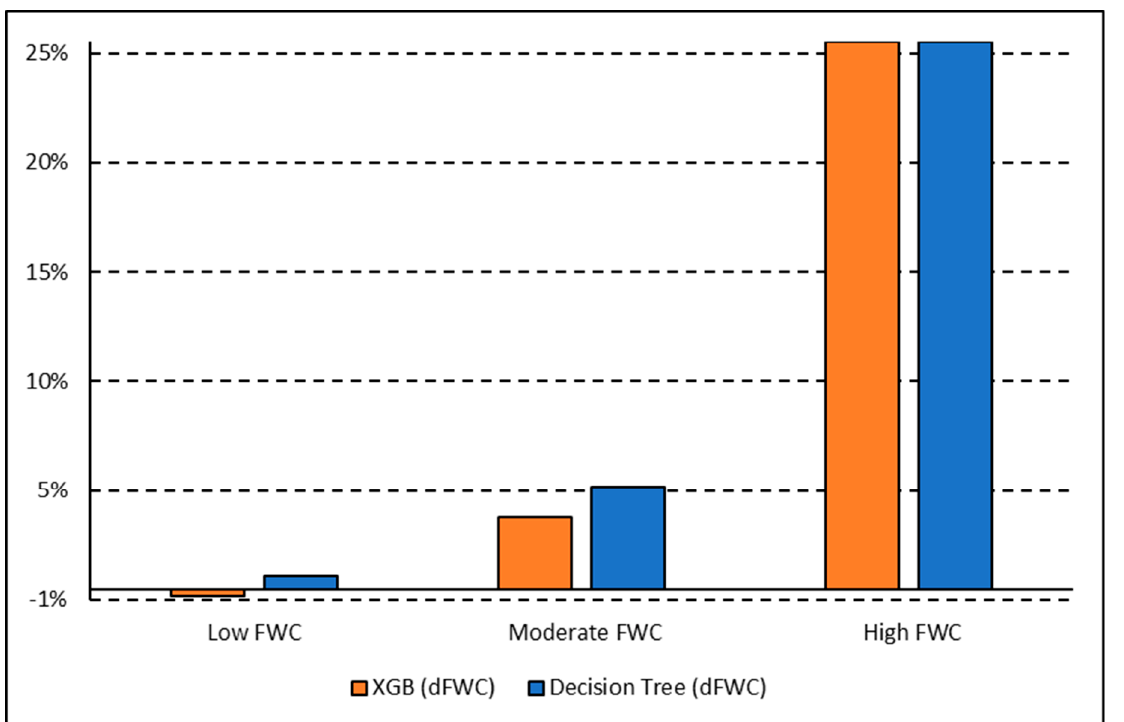
Figure 12. dFWC for the multiclass XGB and Decision Tree models. dFWC is highest for plots with high FWC with Decision Tree and eXtreme Gradient Boost having the highest dFWC (24.99%). This pattern of declined model prediction accuracy occurring with increased site complexity is in agreement with suggestions made by [23].